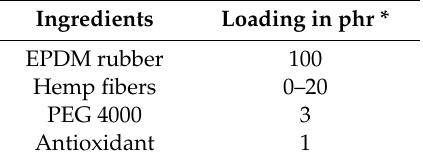
Table 2. Compound